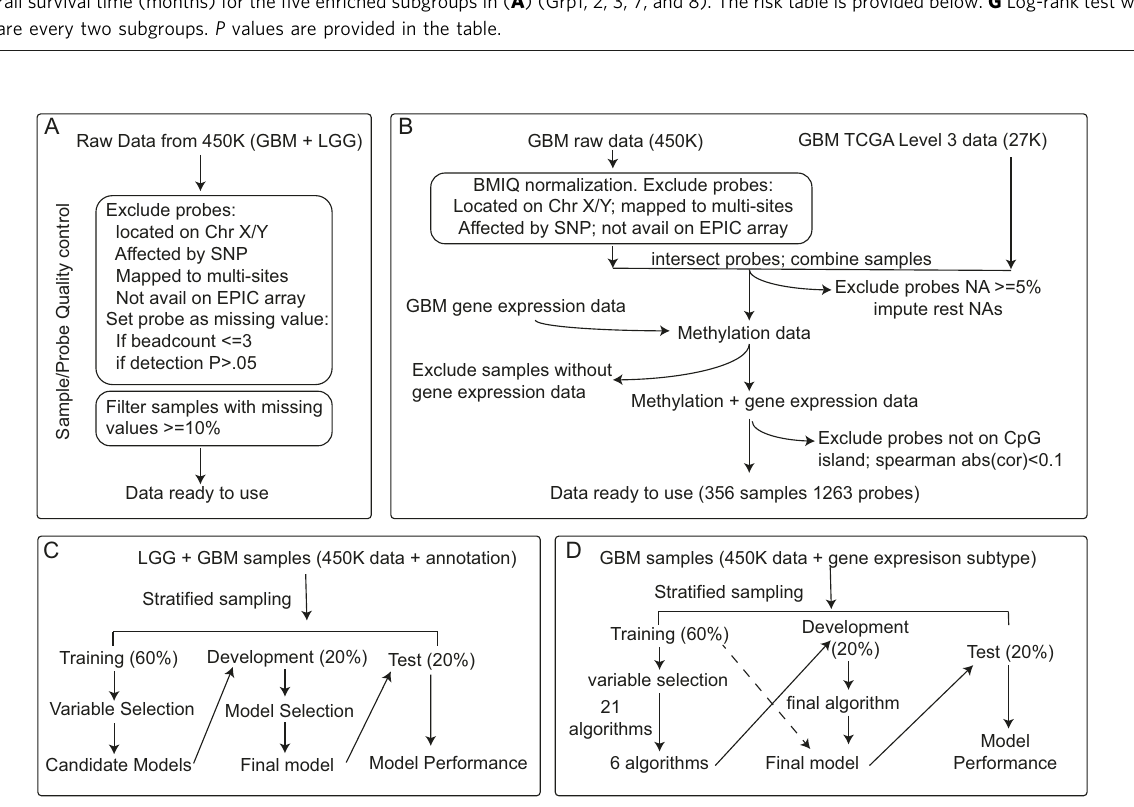
Fig. 5 Work fl ow of data processing and model building. A Data processing procedure for binary genetic alteration prediction with in fi ltrating gliomas. Step by step details are in Supplementary Methods section 1.1.1. B Data processing procedure for gene expression subtype prediction with GBM samples. Step by step details are in “ Methods ” . C Model building procedure for binary genetic alteration prediction. Samples were randomly split into three sets: training set, development set, and test set. The training set was used for variable selection and to build candidate models, then the candidate models were applied to the development set. Based on the prediction accuracy of the development set, the fi nal model was selected. The fi nal model was applied to the test set for model performance evaluation. D Model building procedures for gene expression subtype prediction. GBM samples with DNA methylation and gene expression data available were included. DNA methylation probes were overlapped between the HM27K and HM450K platforms. Samples were split into training, development, and test set. Machine learning algorithms were evaluated on the training set and candidate algorithms were picked out. The development set was used to determine the fi nal algorithm. The fi nal model was built using the training and development sets and validated in the test